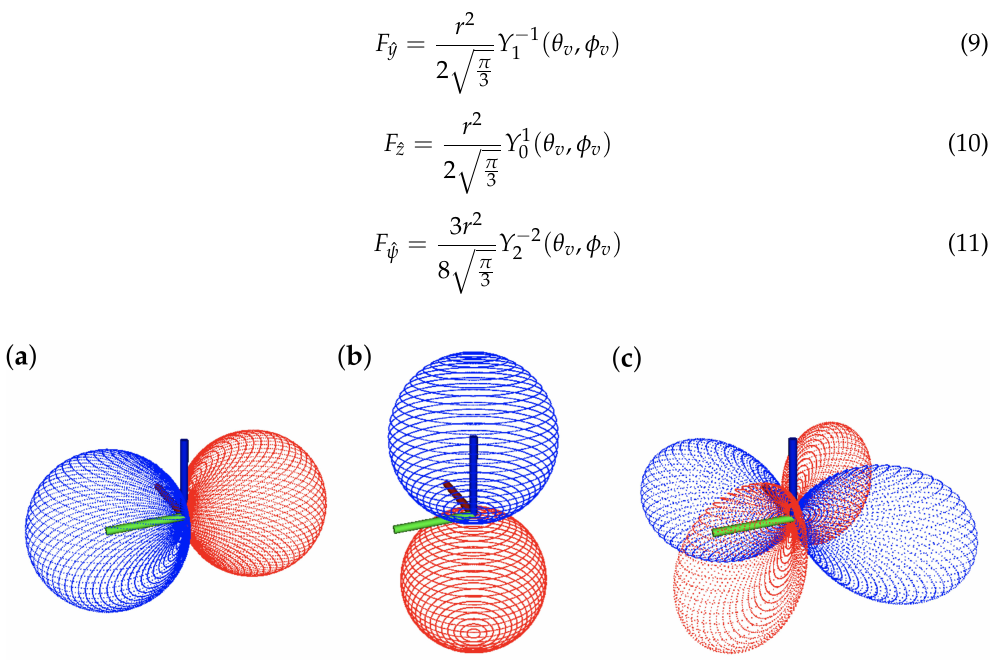
Figure 5. State sensitivity shapes where red points have positive magnitude and blue points have negative magnitude. Origin axis markers are of length 0.5 m. In this linearized example, state sensitivity shapes are simply scaled versions of Laplace spherical harmonics. ( a ) Lateral state y sensitivity shape F ˆ y ; ( b ) vertical state z sensitivity shape F ˆ z ; ( c ) heading state ψ sensitivity shape F ˆ